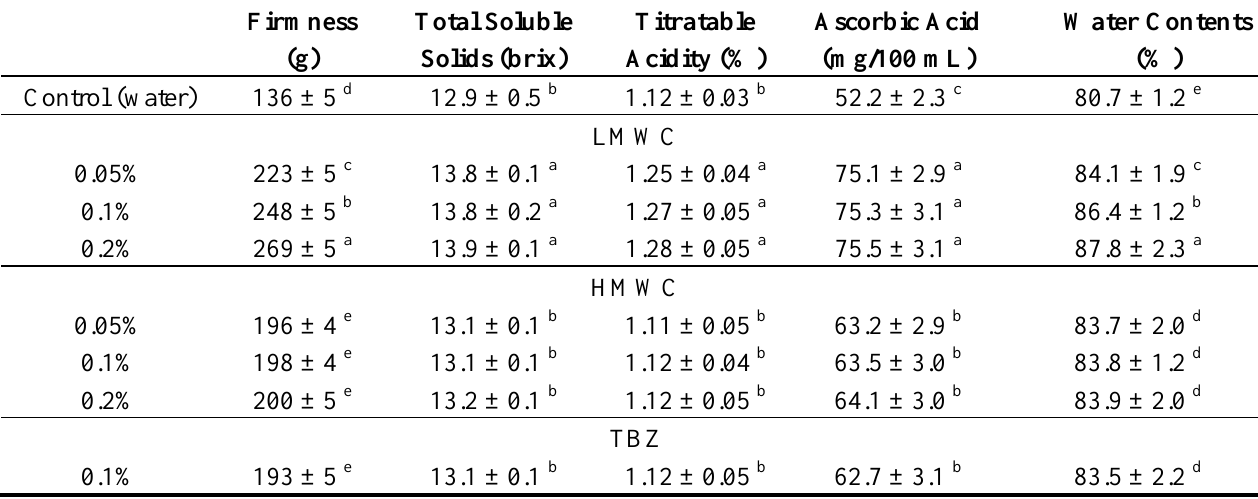
Table 2. Effect of low molecular weight chitosan (LMWC) coating on quality attributes of postharvest Murcott tangor fruits after 56 days of storage at 15 °C 1,2 . Reproduced from Reference